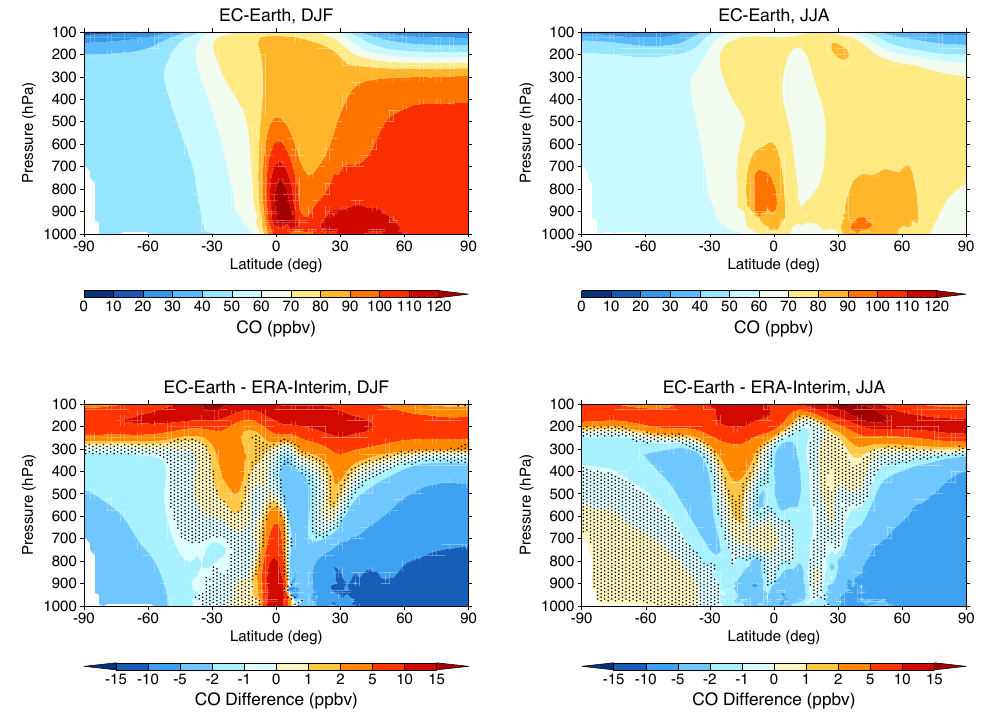
Figure 5. Zonal mean CO mixing ratios in the reference EC-Earth simulation (top) and the differences compared to the corresponding ERA-Interim simulation (bottom) for boreal winter (left) and boreal summer